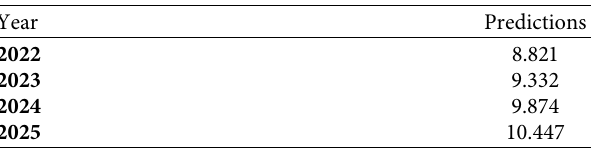
Table 3: | Predictions during the period 2022 to 2025 from NIPC- GM (1,